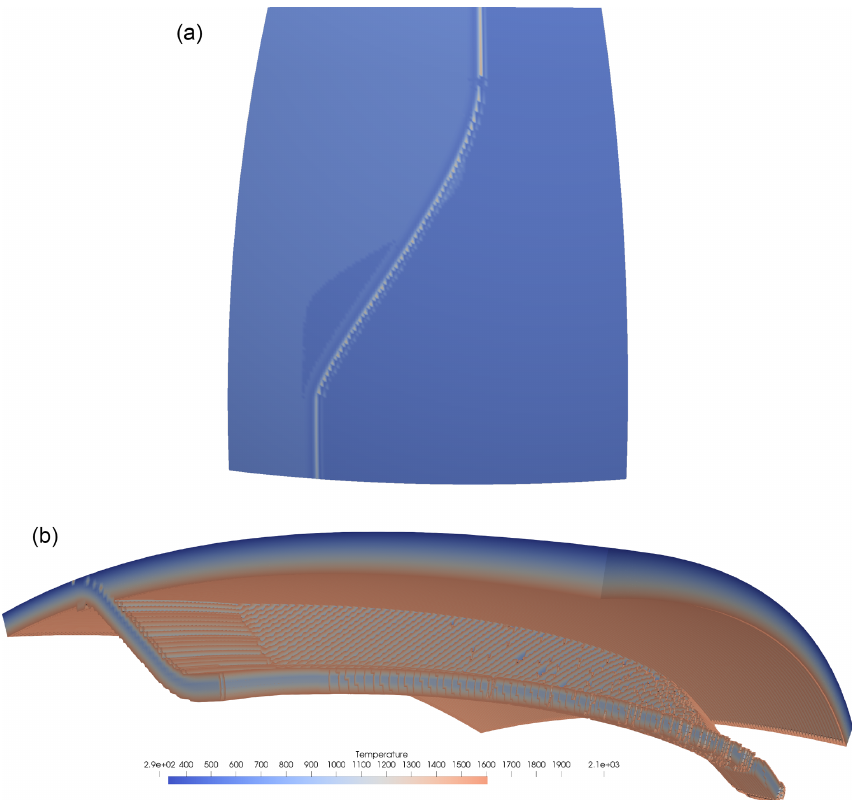
Figure 4. The temperature field of the 3-D subduction example. Note the smooth transition between the upper and lower parts of the subduction system in the top figure and the curved geometry of the slab in panel (b) . For visualization purposes, we have omitted the top 25km of the model in panel (a)